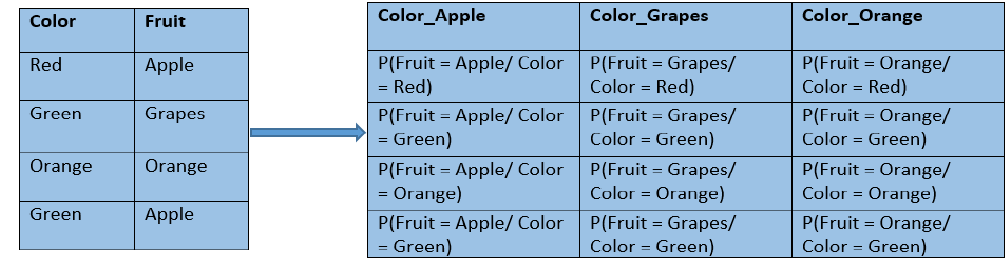
Figure 2. An example of encoding based on target